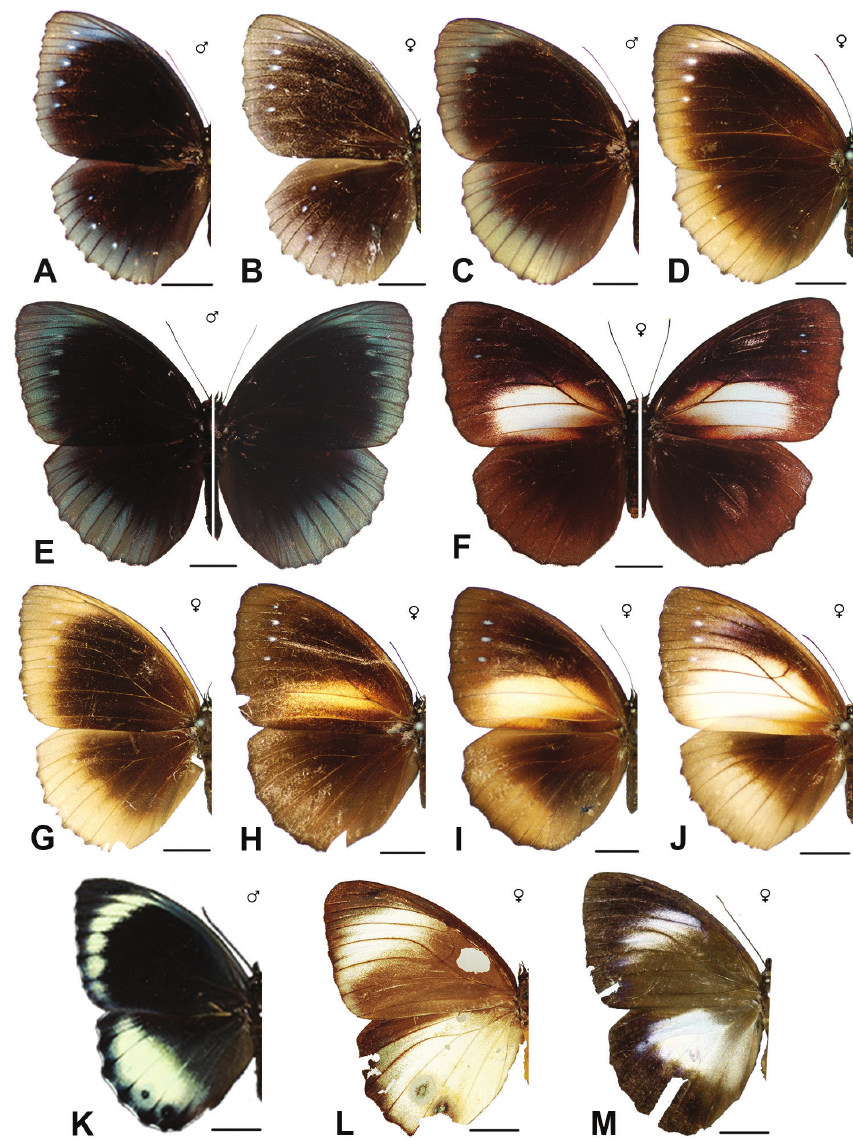
Figure 19. A agondas dampierensis ♂ D NHM Papua New Guinea: Madang, Karkar Island; Syntype B agondas dampierensis ♀ D NHM Papua New Guinea: Madang, Karkar Island C agondas thryallis ♂ D NHM Papua New Guinea D agondas thryallis ♀ D NHM Papua New Guinea E agondas thryallis ♂ D+V NMNH Papua New Guinea: East Sepik, Maprik F agondas thryallis ♀ D+V NMNH Papua New Guinea: Regia, Mapuk G agondas thryallis ♀ D NHM Indonesia: Papua, Yos Sudarso Bay H agondas thryallis ♀ D NHM Indonesia: Papua, Yos Sudarso Bay I agondas thryallis ♀ D NHM Indonesia: Papua, Yos Sudarso Bay J agondas thryallis ♀ D NHM Indonesia: Papua, Yos Sudarso Bay K agondas australiana ♂ D MCZ Australia: Queensland, Claudie River L agondas australiana ♀ D NHM Australia: Queens- land M agondas australiana ♀ D MCZ Australia: Queensland, West Claudie